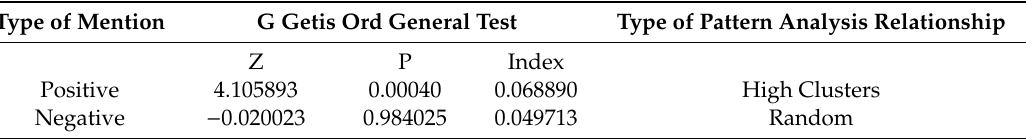
Table 7. G Getis Ord test on